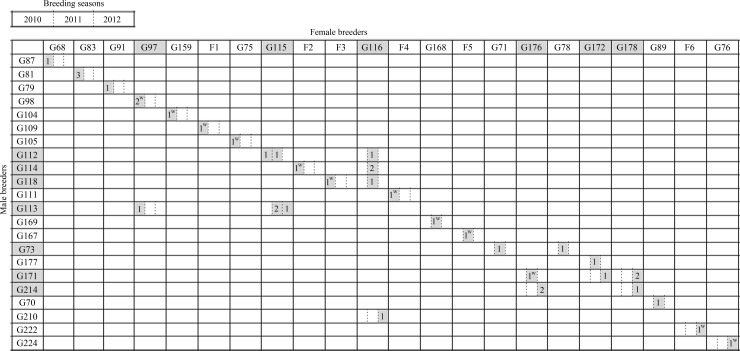
Mating behavior of breeders of Hippocampus guttulatus in captivity among three breeding seasons inferred by genetic parentage analysis.First reproductive event of male parents in the wild (w), either sampled with one known or unknown female (see Table 3) in the field surveys. Polygynous and polyandrous breeders among breeding seasons were marked in grey.